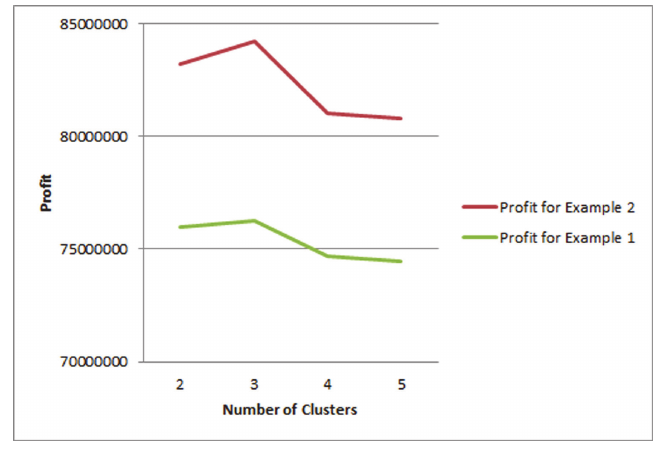
Fig. 2. Number of clusters against the profit for examples 1 and